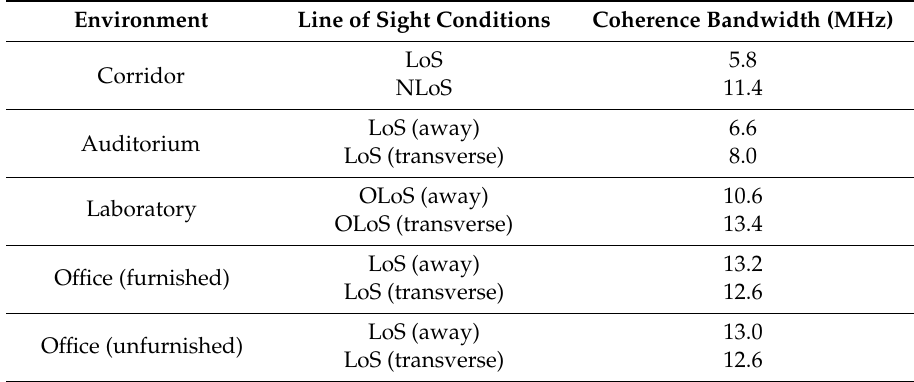
Table 3. Measured coherence bandwidth (MHz) at correlation level 0.9, for which 90% of cases are larger.